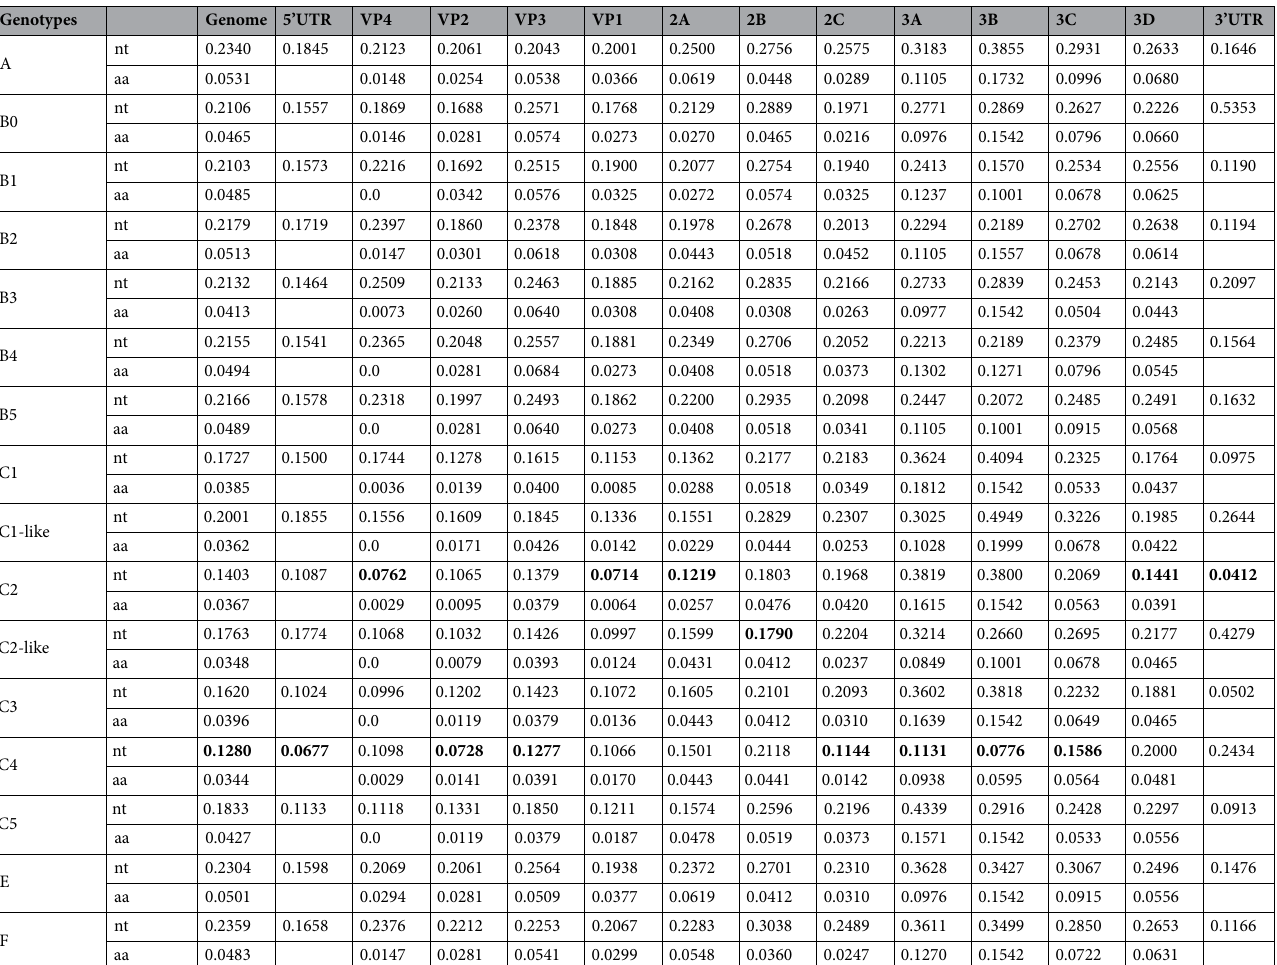
Table 1. Average genetic distances of nucleotide and amino acid sequences in different gene fragment between DL71 and other genotypes or subgenotypes of EV-A71. The average genetic distance of nucleotide and amino acid sequences in different gene fragment between DL71 and the reference strains was estimated by the DISTANCE program (Compute between Group Mean Distance) in MEGAX. The numbers of base and amino acid substitutions per site from averaging over all sequence pairs between groups are shown. The nucleotide sequences comparison was conducted using the Kimura 2-parameter model with both transitions and transversions substitutions. The amino acid sequences comparison was conducted using the Poisson correction model with all substitution. The bootstrap method with 1000 replications was selected as the variance estimation method. The smallest genetic distances of nucleotide sequences in different regions are marked in bold. The information of 222 EV-A71 strains used in the analysis was listed in the supplementary table S2. nt, nucleotide. aa, amino